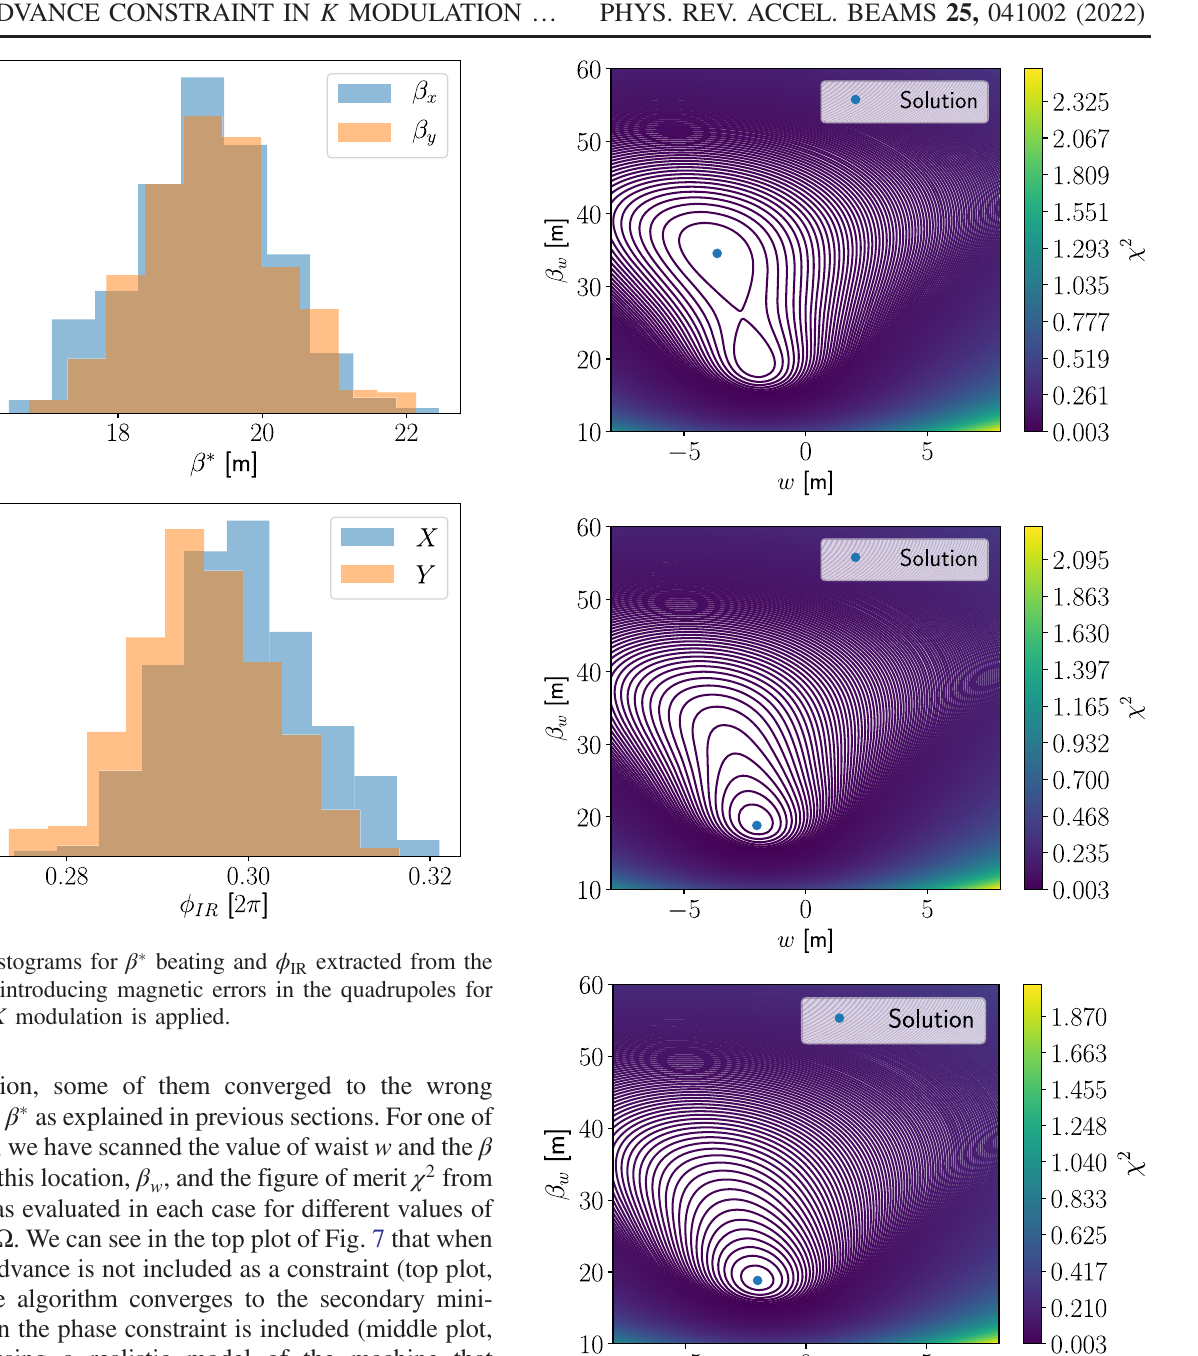
extracted from the IR